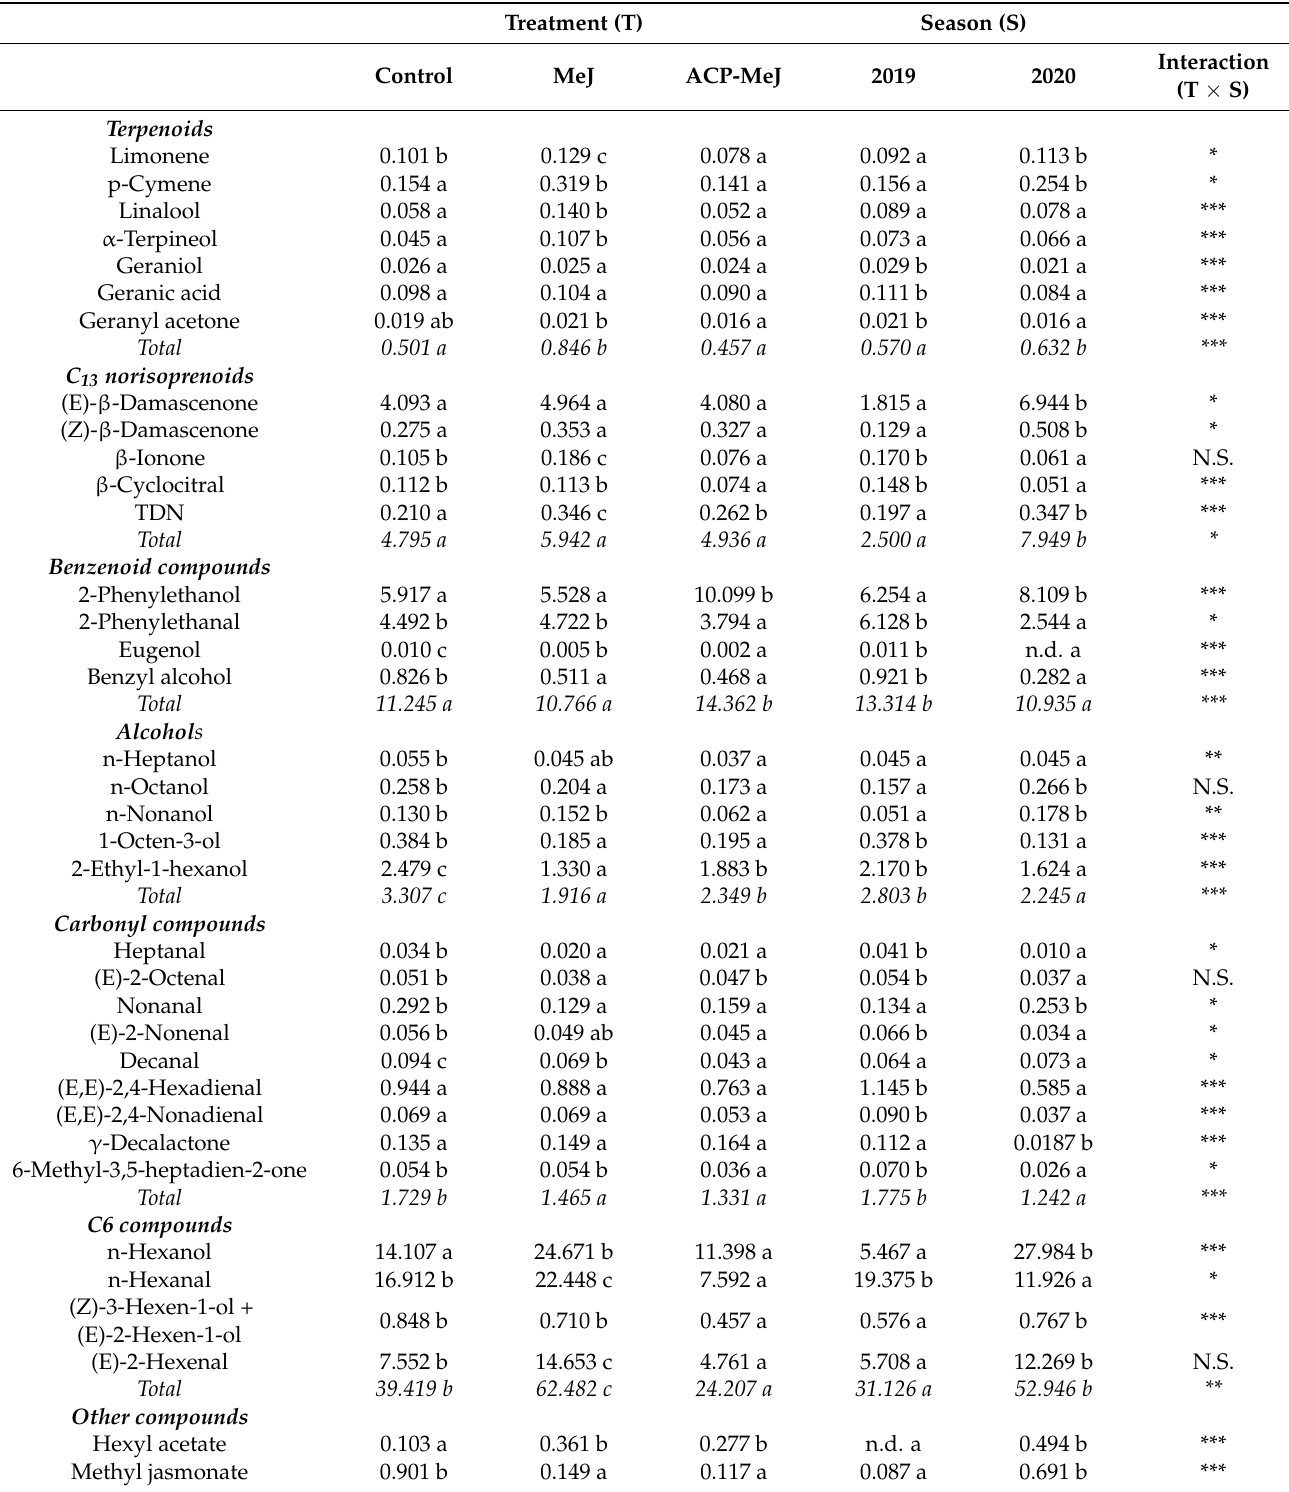
Table 4. Multifactor analysis of variance of grape aroma compounds (expressed as µ g/L) with the two factors studied: treatment (control, MeJ, ACP-MeJ) and season (2019 and